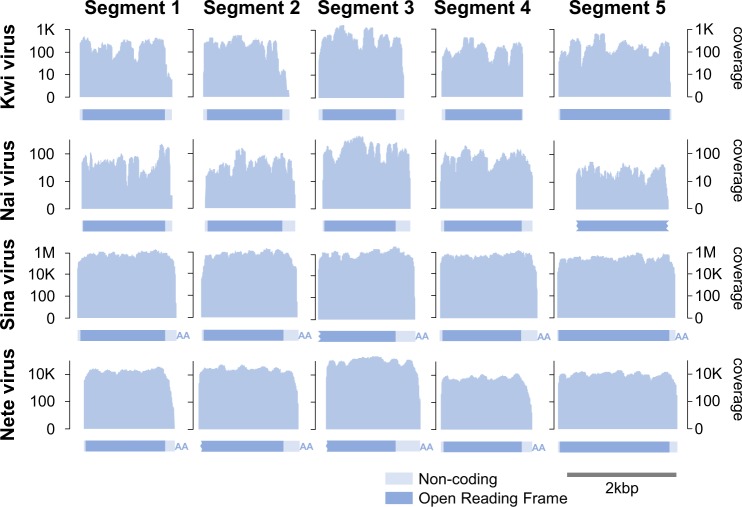
Virus segments and sequencing coverage. Panels show the structure and fold-coverage for each of the five segments (columns), for each of the four founding Quenyaviruses (rows). Graphs represent fold-coverage on a log10 scale, with the structure of the segment annotated below to scale (dark: coding, pale: non-coding). Assembled contigs that terminated with a poly-A tract are denoted ‘AA’, and potentially incomplete open reading frames indicated with a jagged edge.